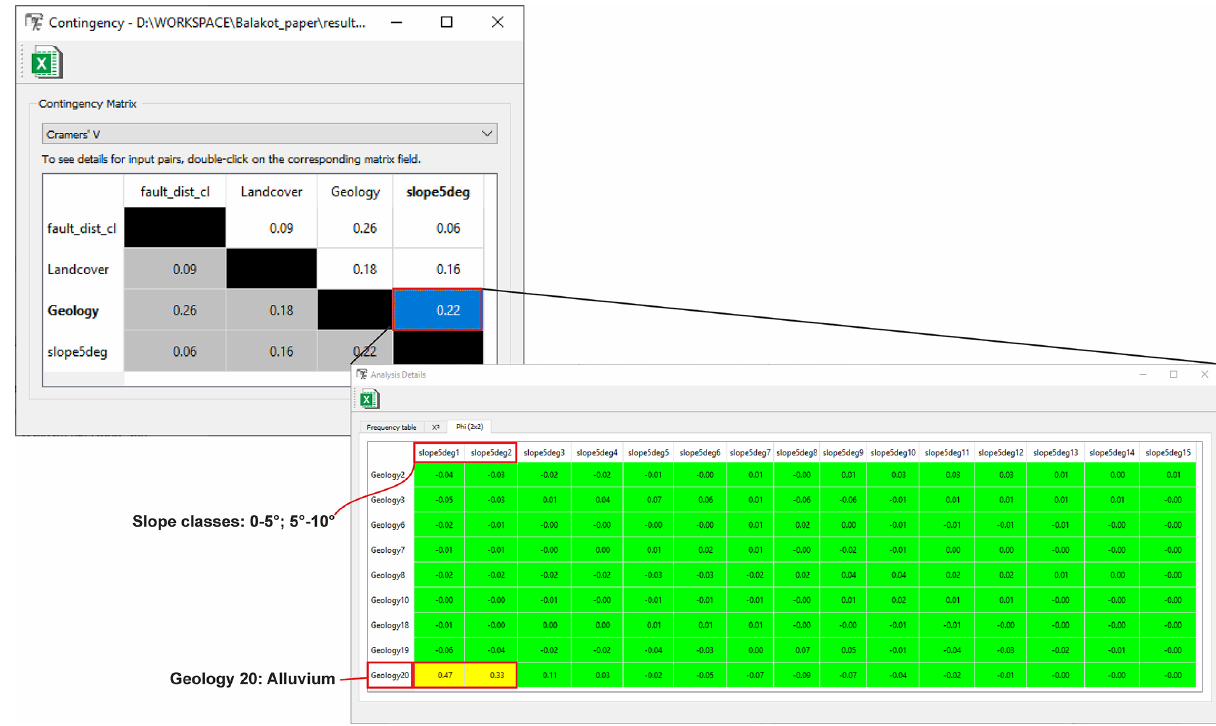
Figure 7. Example for the contingency result output: the first window represents an allover contingency matrix between multiclass parameters based on Cramer’s V. On double-click, the detailed contingency between Geology and slope5deg is callable.